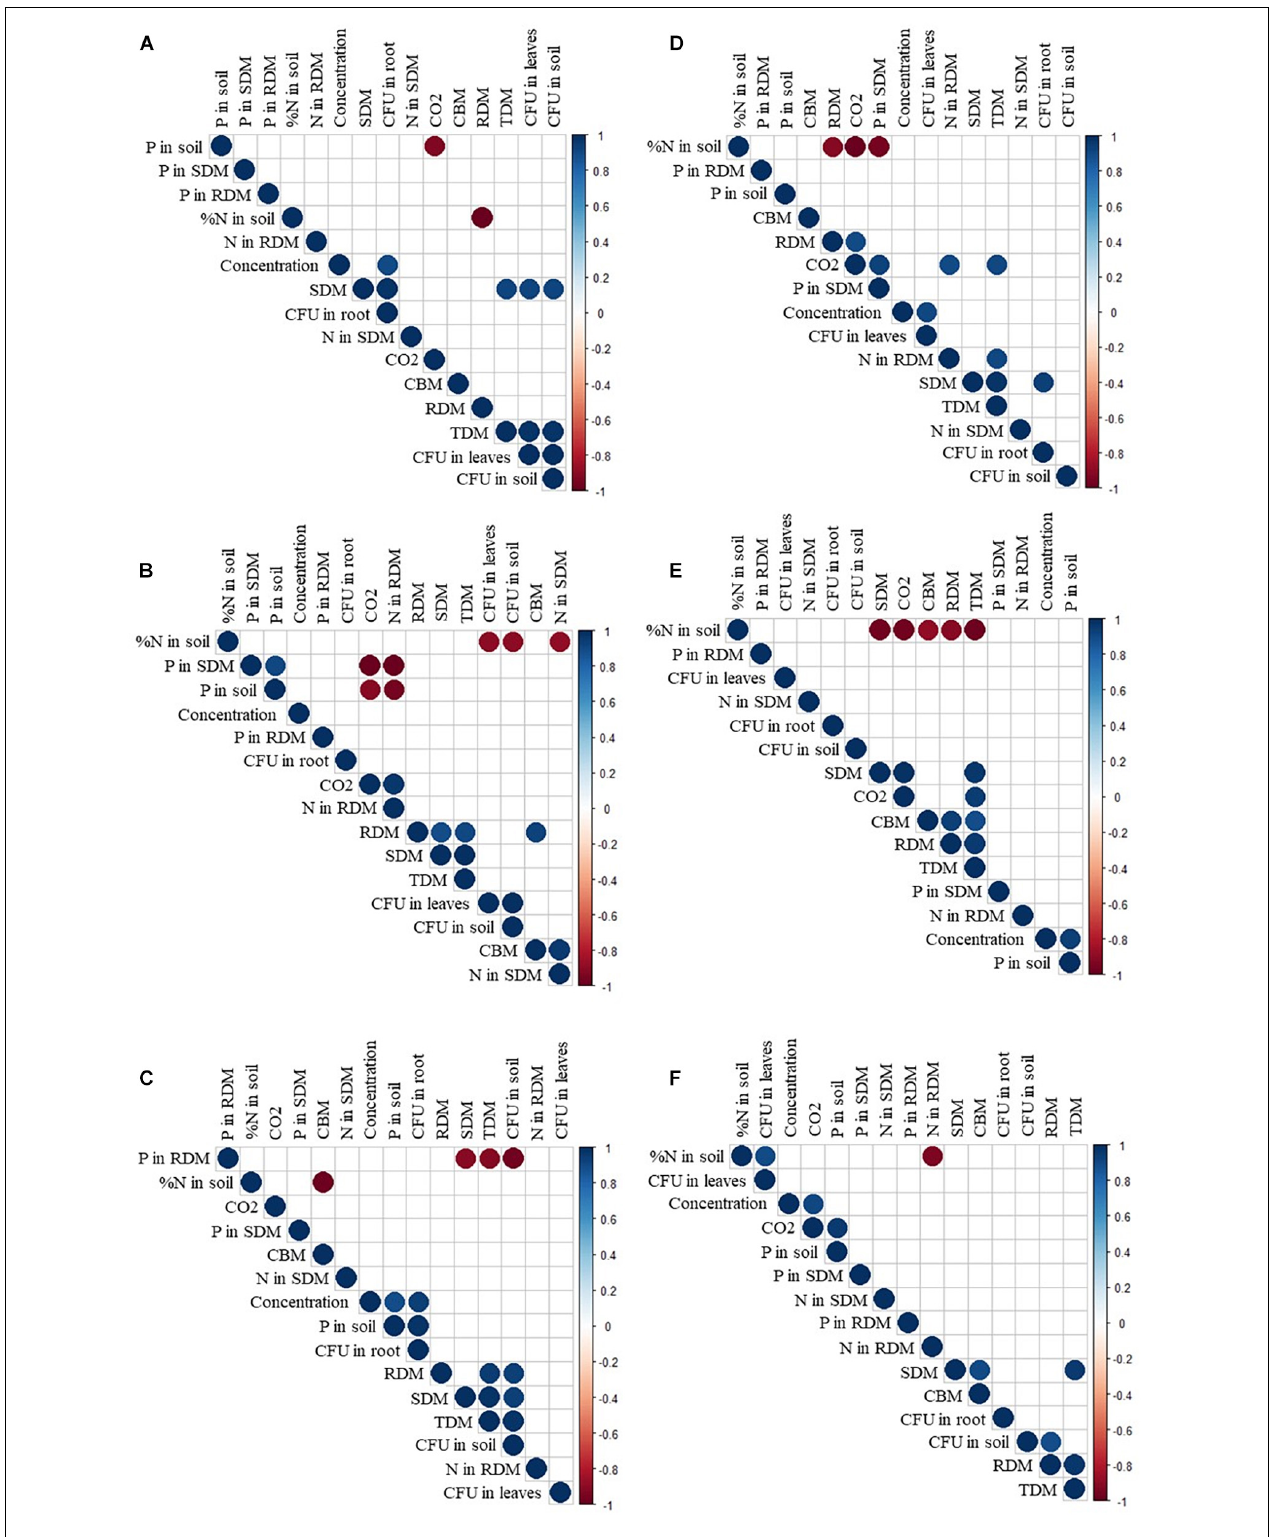
FIGURE 10 | Correlation of growth promotion variables and concentration of Aspergillus brasiliensis (A) , Aspergillus sydowii (B) , Aspergillus sp. (C) , Bacillus velezensis (D) , and Bacillus subtilis strain Bs248 (E) and Bs290 (F) . P, phosphorus; N, nitrogen; SDM, shoot dry matter; RDM, root dry matter; TDM, total dry matter; CO 2 , respiratory activity; CBM, biomass carbon; and CFU, colony-forming units.